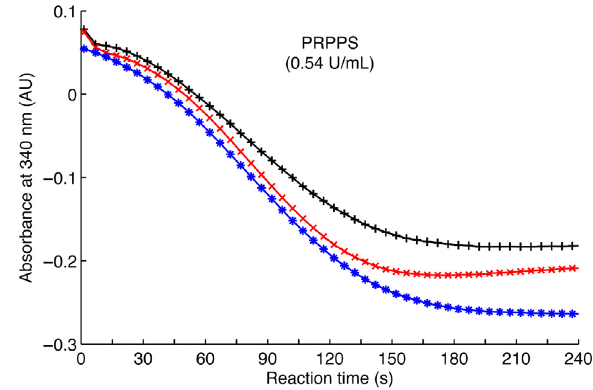
Figure 8. Enzymatic activity assay of PRPP synthetase. The activity was calculated using the maximum linear rate observed in each trace (Equation 1) and reported as the average of triplicate measurements. A typical activity is shown.